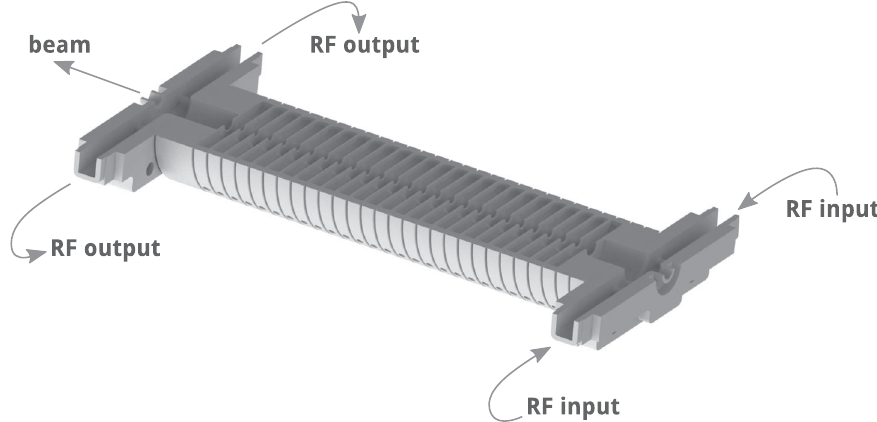
FIG. 3. Longitudinal cross section of a 3D model of the CLIC prototype accelerating structure installed in the Two-beam Test Stand in